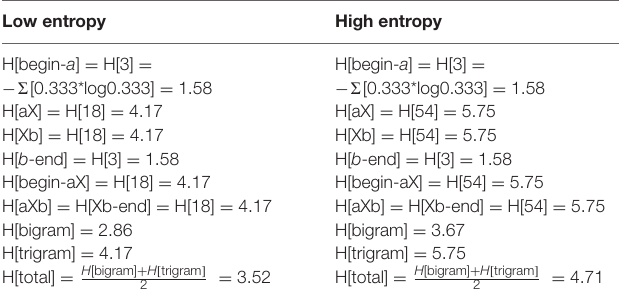
TABLE 2 | Entropy values for the two entropy versions of the aXb